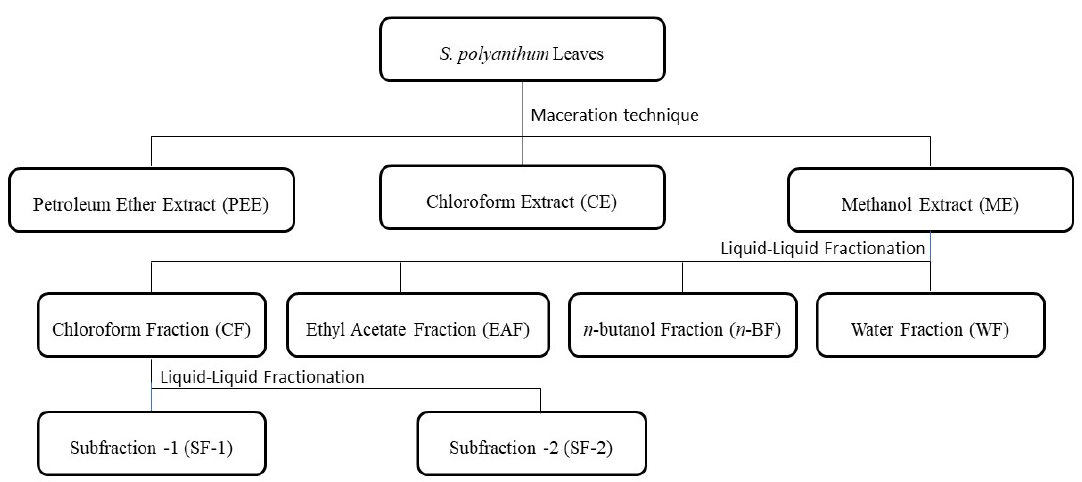
Figure 9. Schematic representation of bioactive-guided fractionation of S. polyanthum leaves.